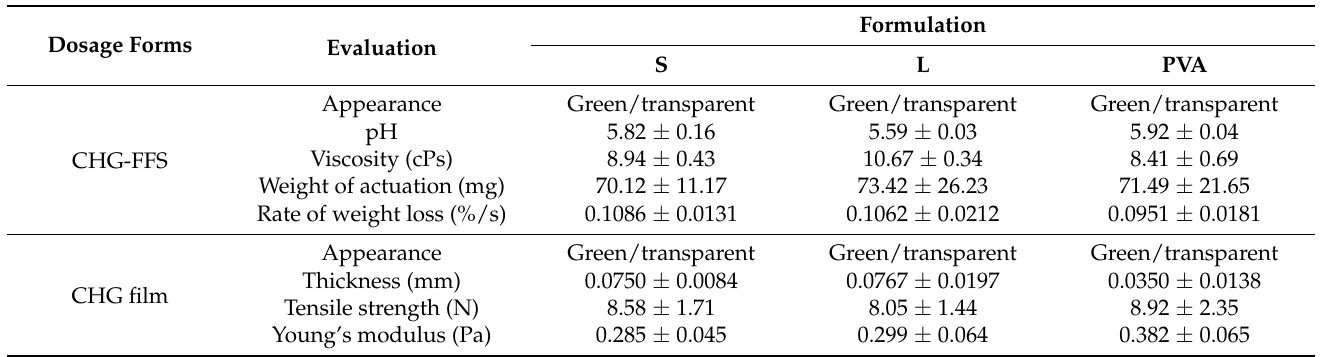
Table 4. In vitro evaluation of CHG-FFS and CHG